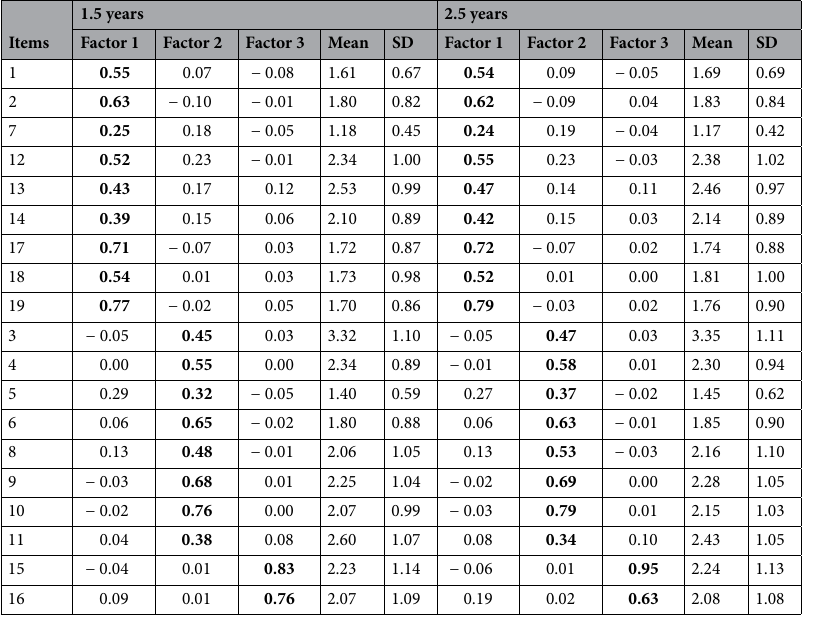
Table 2. Comparison of factor loadings for the three identified factors and mean values with standard deviation (SD) at 1.5 and 2.5 years postpartum. Bold type indicates factor loadings contributing to the attributed